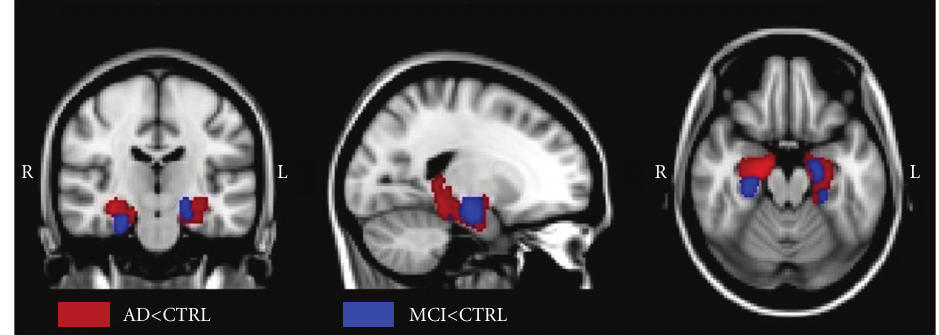
Figure 4: Nonparametric statistical results of voxelwise analysis in SPM8, on probability distribution of the tract connecting hippocampus with PC/PCC in MCI patients, AD patients, and healthy controls ( P < . 05, FWE correction). The red regions represent the areas in which tract connecting hippocampus with PC/PCC is significantly degenerated in AD patients compared to CTRL. The blue regions represent the areas in which this tract is significantly degenerated in MCI patients compared to